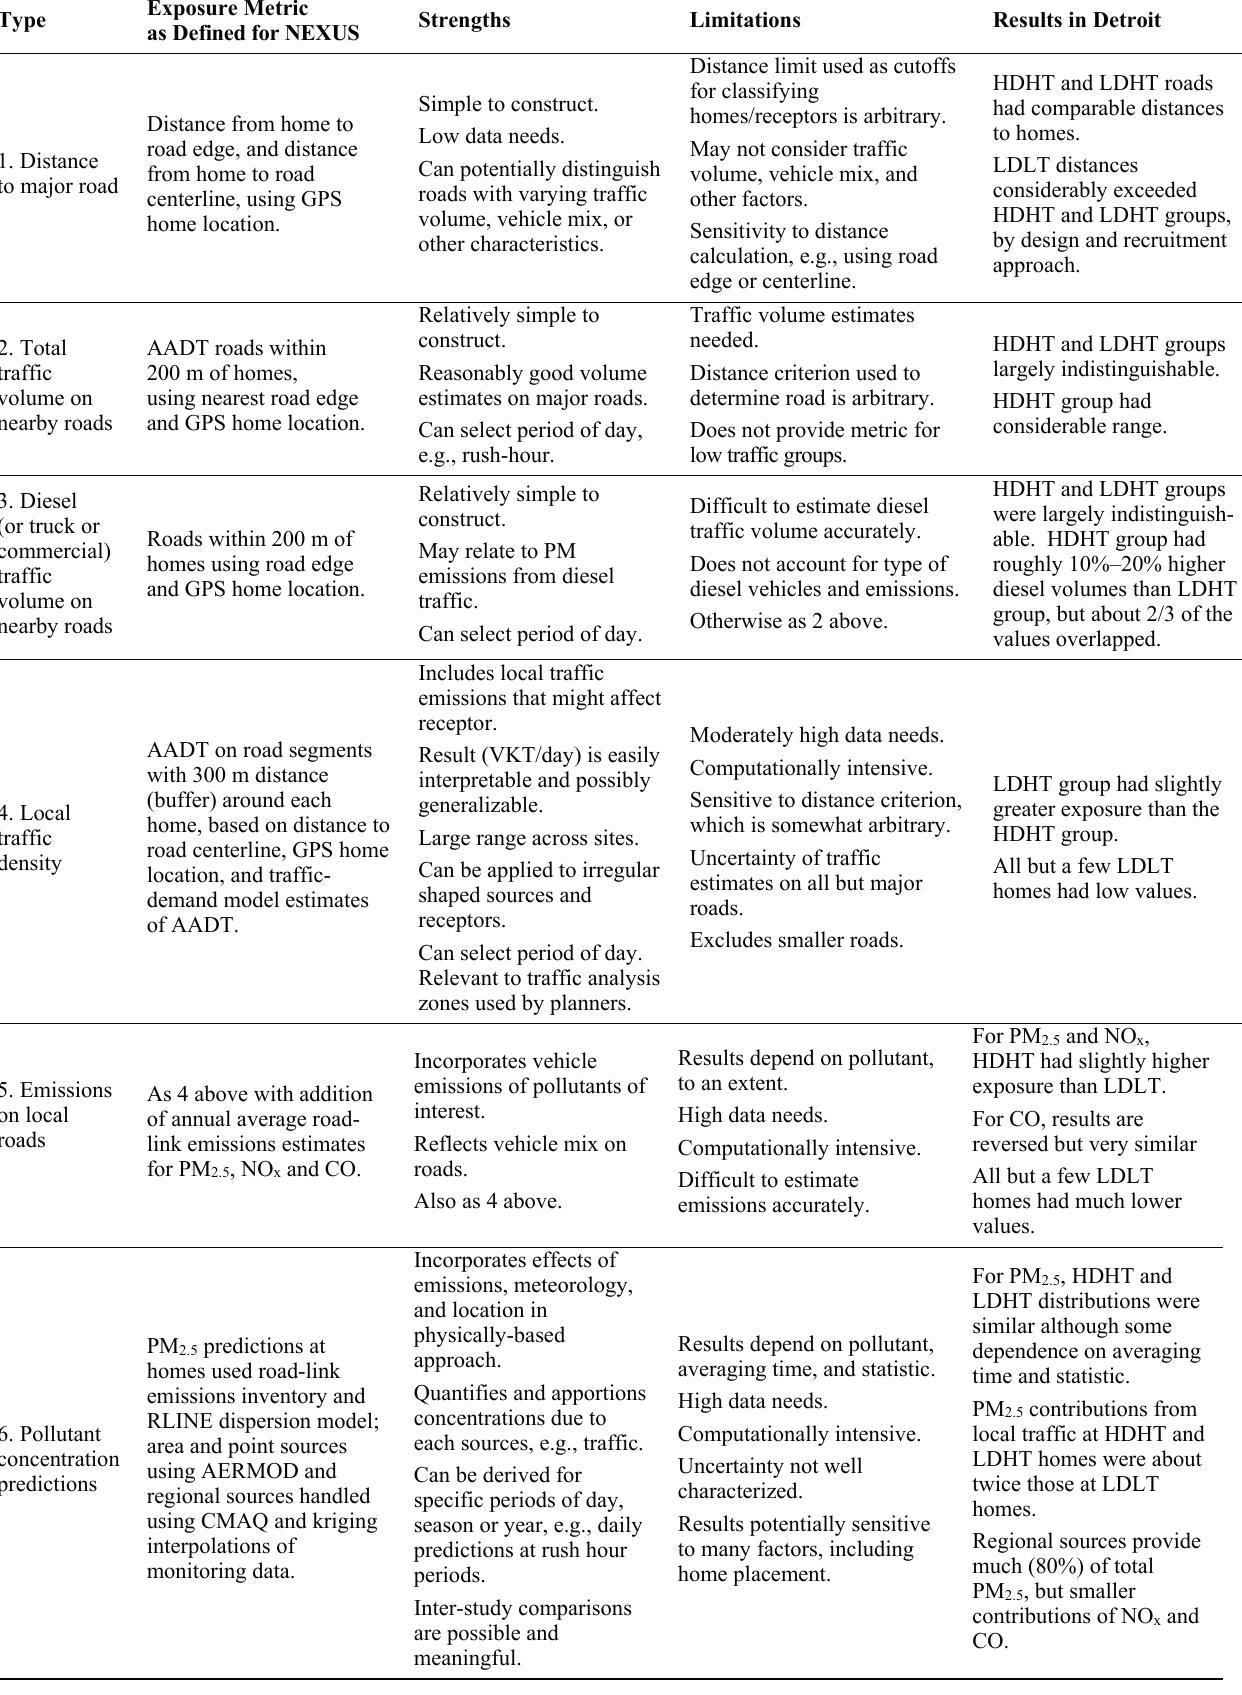
Table 5. Summary of metrics used for exposure to traffic-related air pollutants in